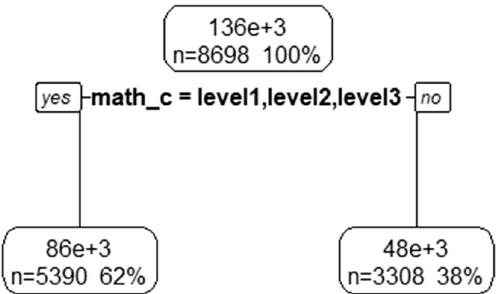
Fig. 2 Mplus Tree with Complexity Parameter ( cp ) 0.01. The left branch at each partition point has = observations that meet the condition (i.e. the result of testing the condition is “yes”). The right branch at each partition point has observations that do not meet the condition (i.e. the result of testing the condition is